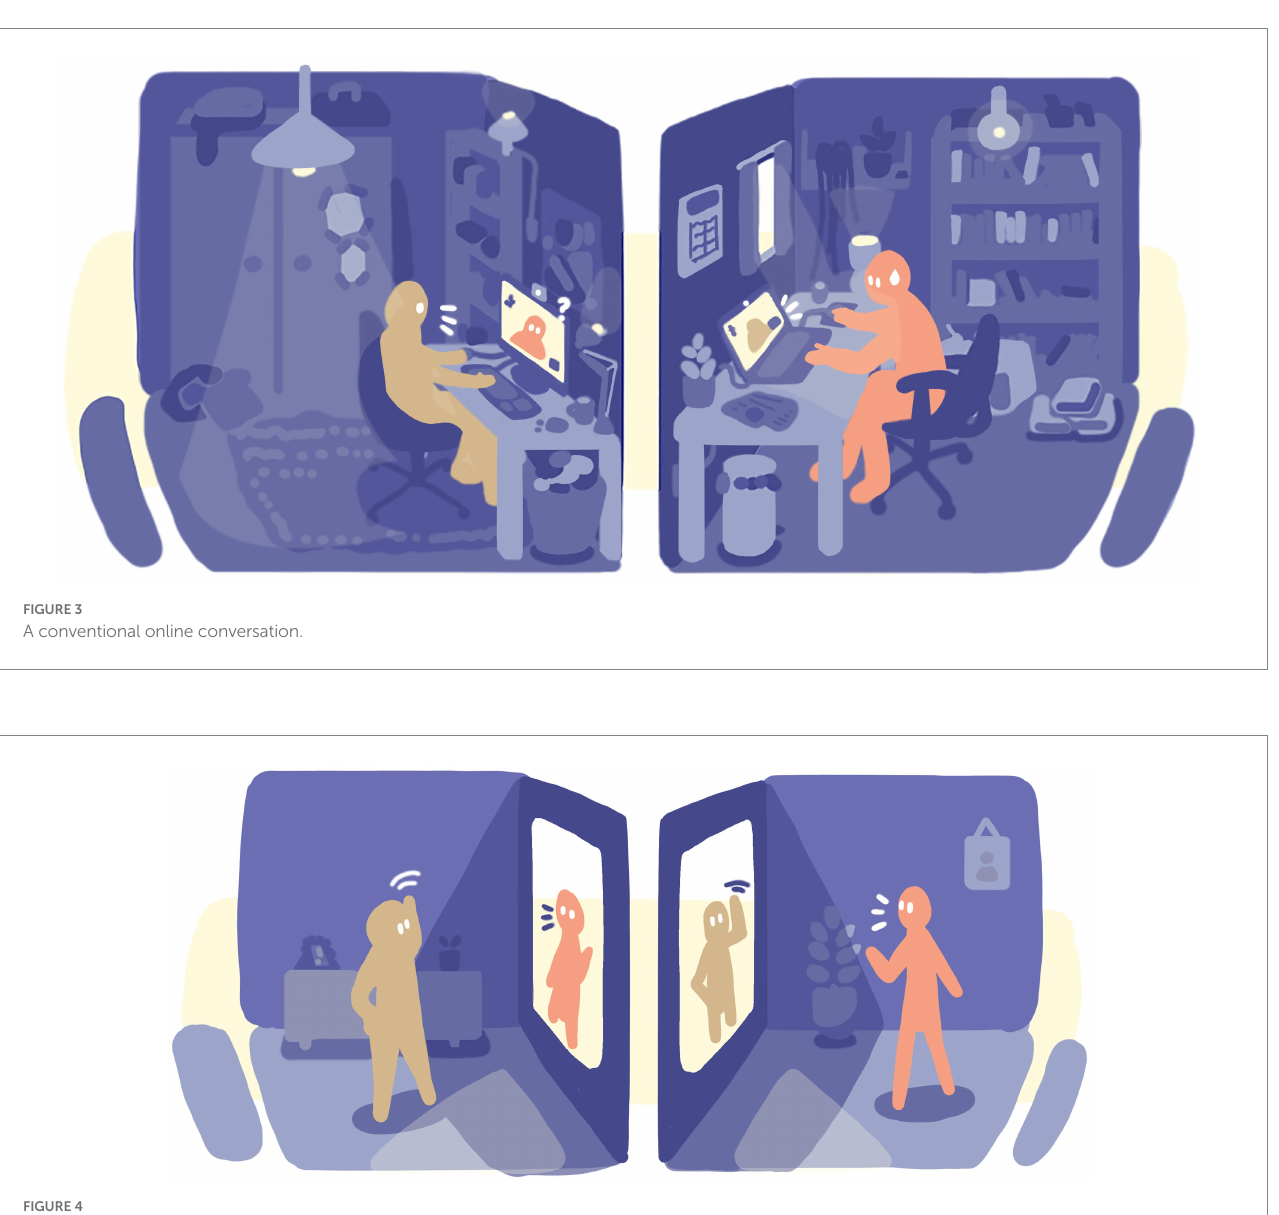
FIGURE 4 Liminal Design in practice. A space for deep presence in online